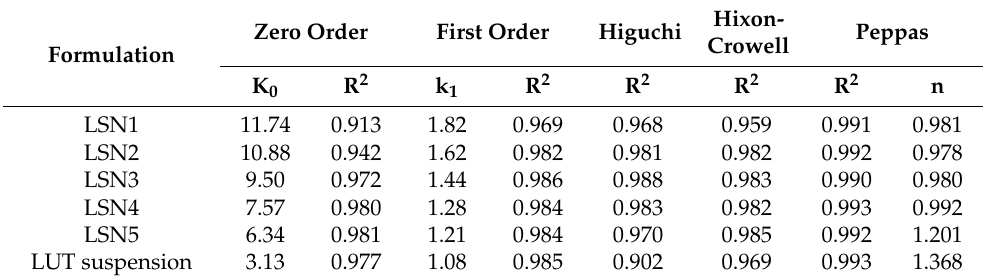
Table 5. Correlation coefficients and kinetics of drug release from SNEDDS (LSN1-LSN) and LUT